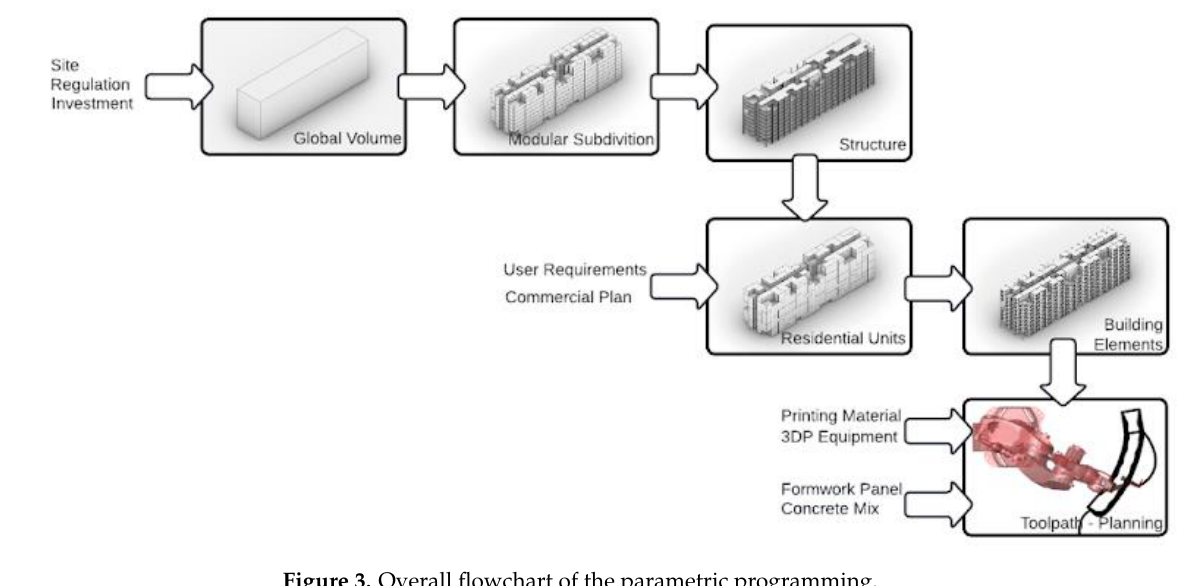
Figure 3. Overall flowchart of the parametric programming.